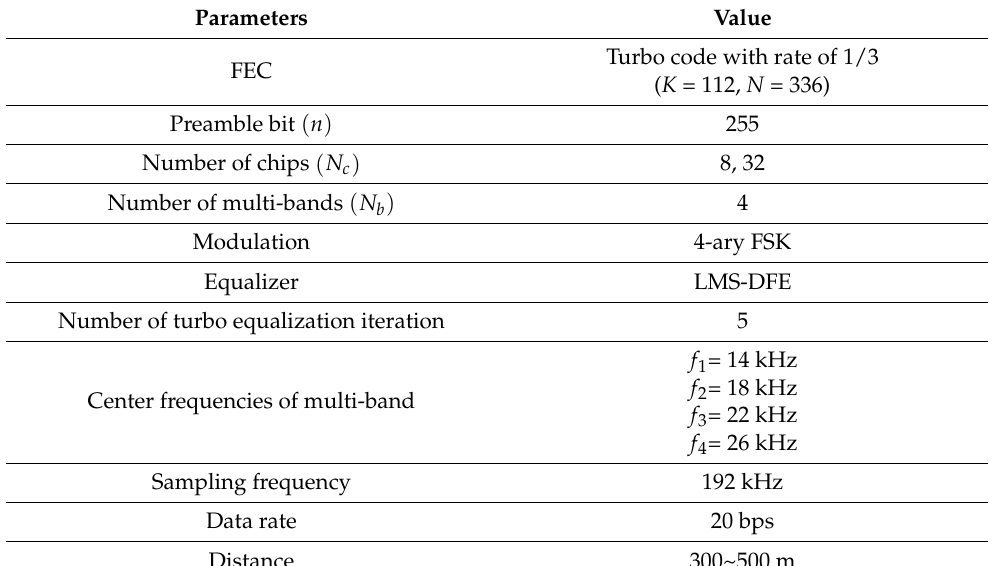
Table 2. Experimental parameters.